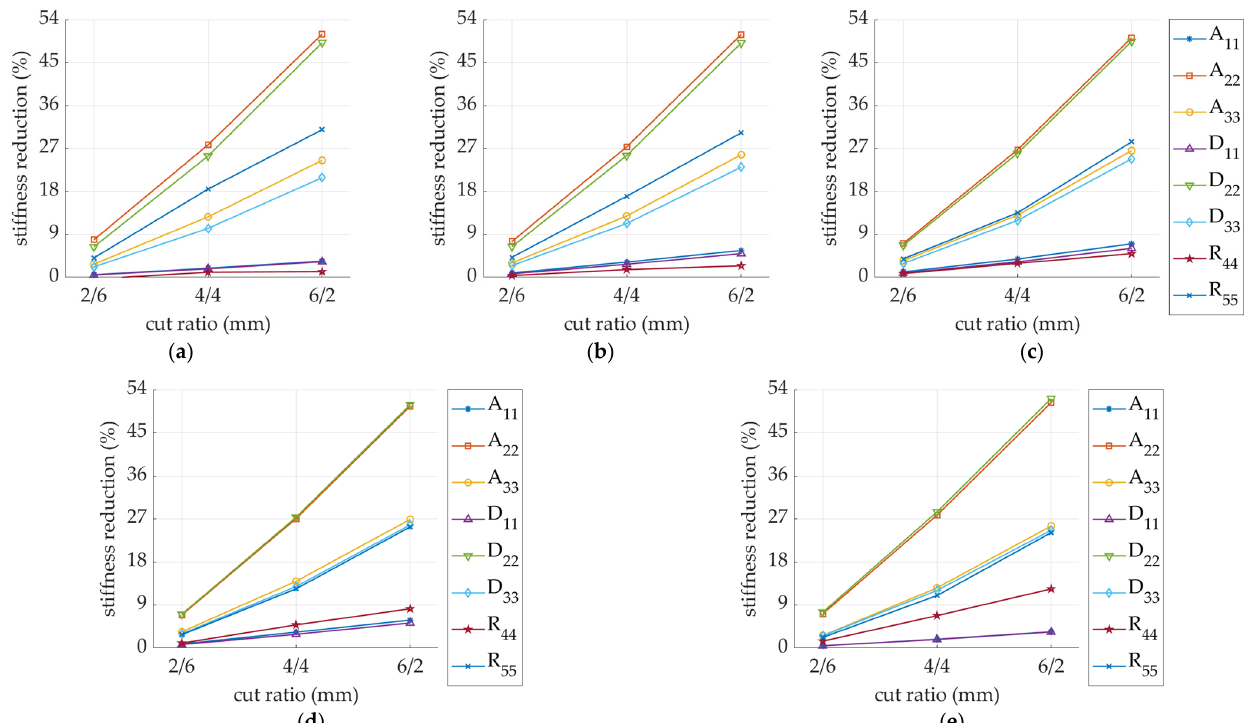
Figure 13. Stiffness degradation in sample SW: ( a ) F-15; ( b ) F-30; ( c ) F-45; ( d ) F-60; ( e ) F-75. Three types of perforations were analyzed (2/6 mm, 4/4 mm, or 6/2 mm).